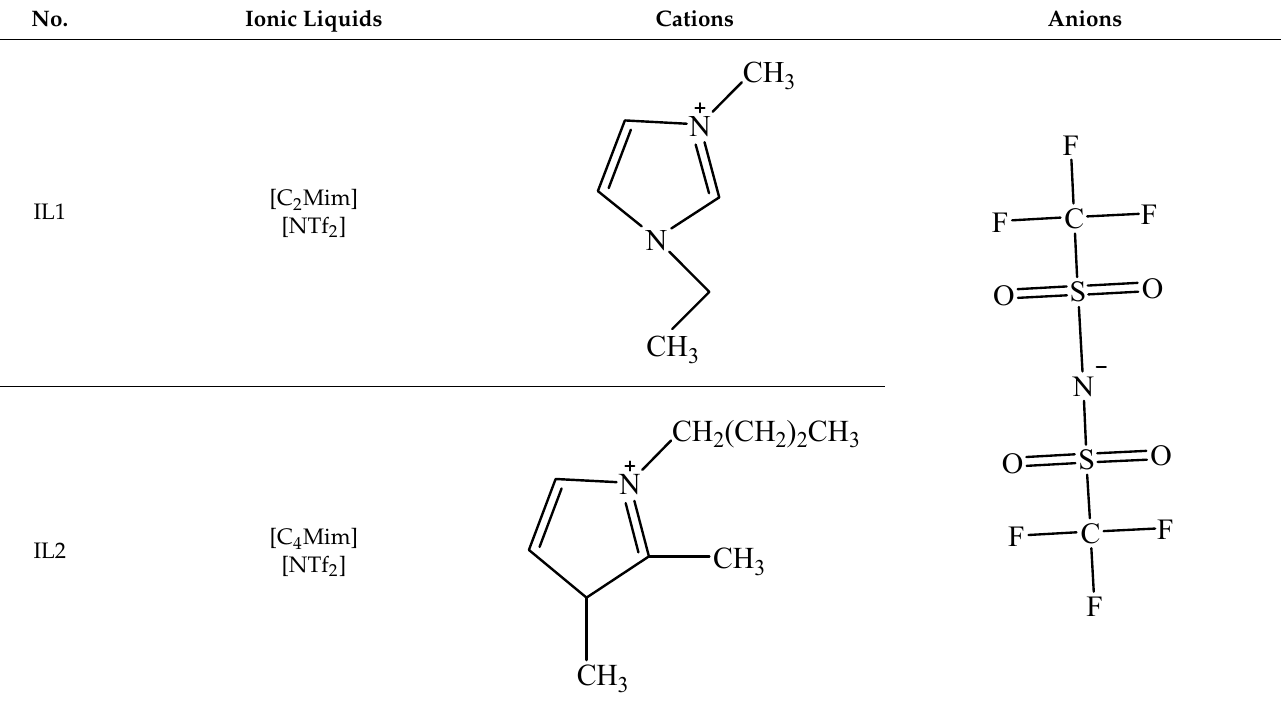
Table 2. Chemical Structure of the cations and the imide anion of the ILs used in this work with their abbreviations.